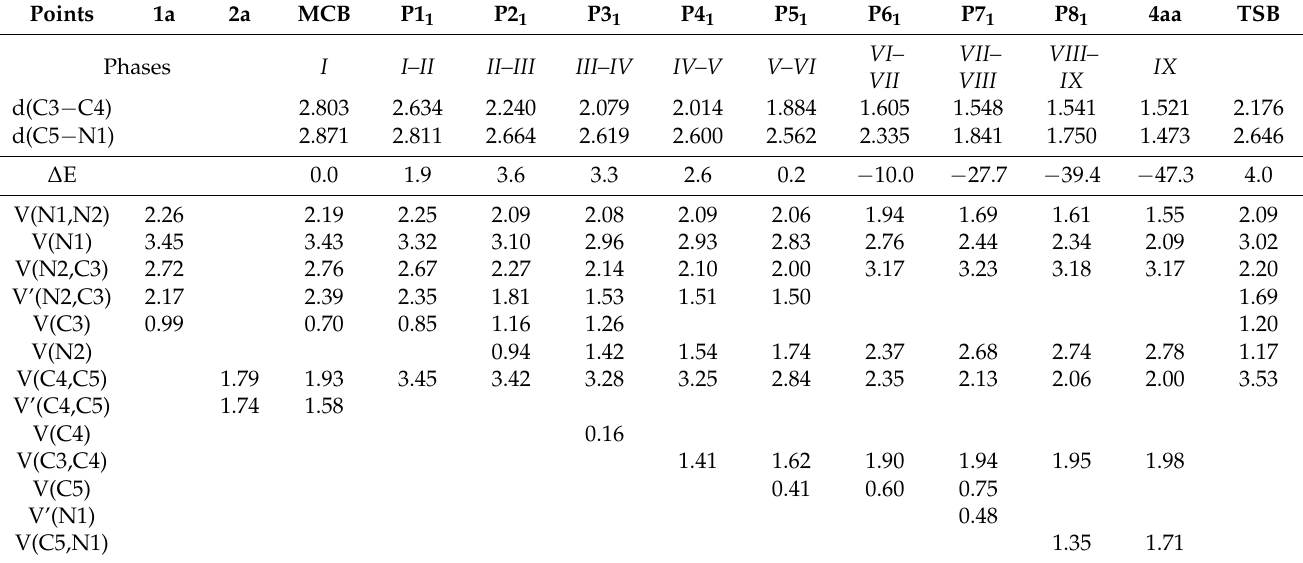
Table 7. BET analysis results for the formation of acyclic adduct Z1 . The table also lists the structures